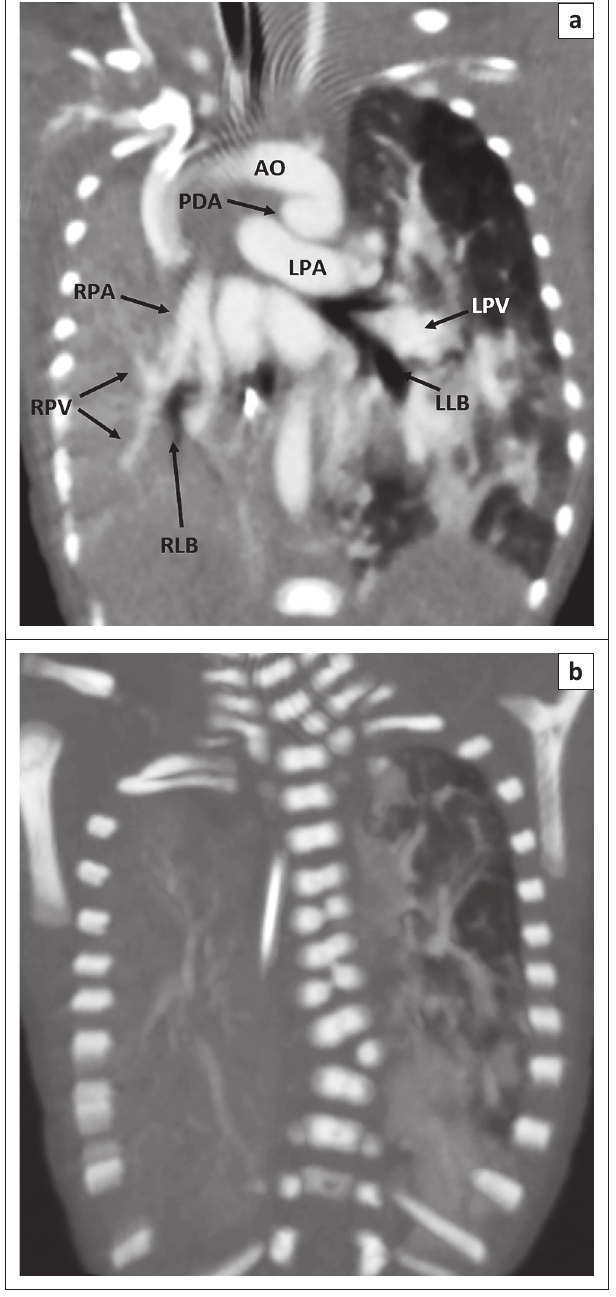
FIGURE 1 : Computed tomography angiography thorax (A) demonstrates hypoplastic right lung, right lower lobe bronchi (RLB), right pulmonary artery (RPA) and veins (RPV). The right hemithorax volume is reduced with ipsilateral mediastinal shift. Large patent ductus arteriosus (PDA) connecting with the aorta (AO). Posterior CT imaging (B) demonstrates left hemivertebrae at C7/T1 and T8/T9, butterfly vertebrae of T5 and T7, and left C7/T1 cervical